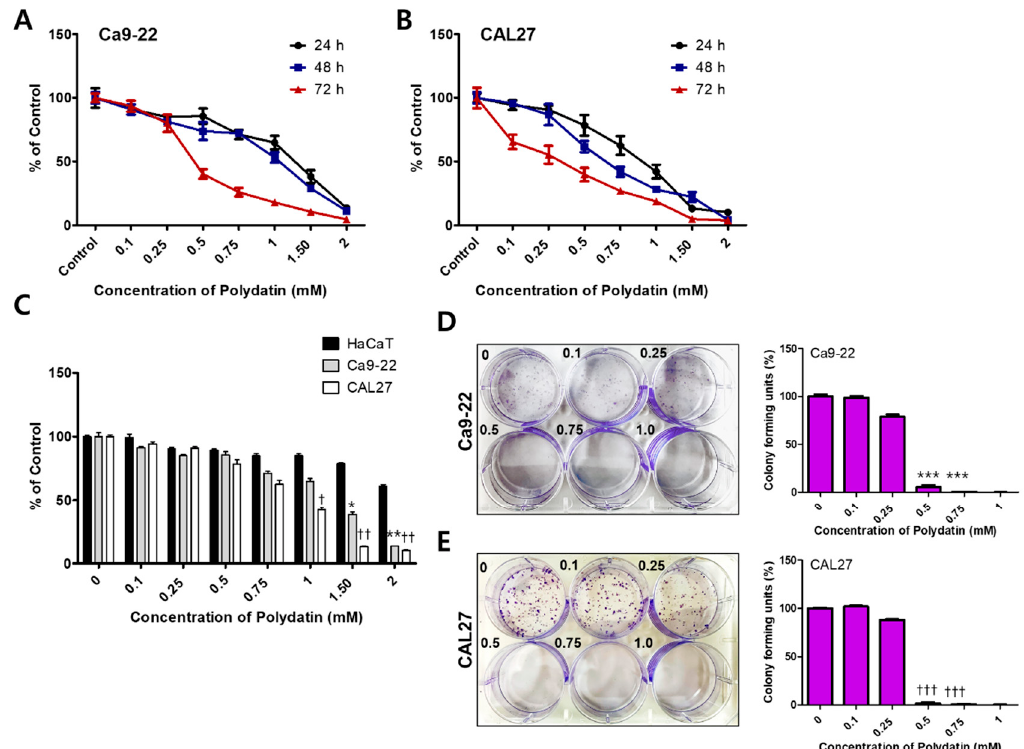
Figure 1. Inhibitory effect of polydatin on OSCC cell viability and proliferation. Ca9-22 ( A ) and CAL27 ( B ) cells were treated with 0–2 mM polydatin for 24–72 h and then their viability was assessed. ( C ) Comparison of cell viability in human keratinocyte HaCaT and OSCC (Ca9-22 and CAL27) cells by polydatin treatment for 24 h. Ca9-22 ( D ) CAL27( E ) cells were treated with 0–1 mM polydatin for 7 days. The Ca9-22 ( D ) and CAL27( E ) cell colonies that formed were stained with 1% crystal violet and then photographed with a digital camera. The number of colonies that formed in each group was counted and graphed. Graphs showing the formation rate of each colony, with the control group representing a 100% formation rate. Results are expressed as mean ± SD. Data were derived from three independent experiments. (Ca9-22: * p < 0.05, ** p < 0.01, *** p < 0.001; CAL27: † p < 0.05, †† p < 0.01, ††† p < 0.001).